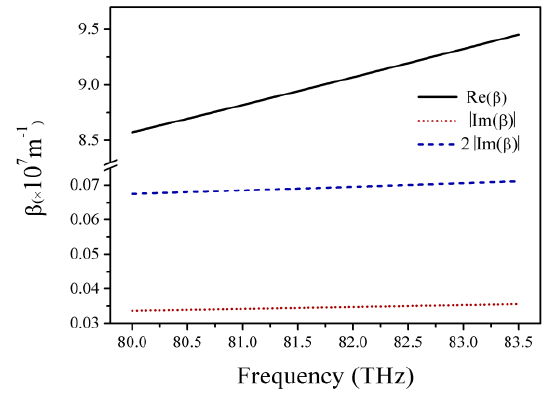
Figure 4. The real part and the absolute value of the imaginary part of the propagation constant as a function of frequency, where the chemical potential of the grapheme is 0.5 eV, respectively.